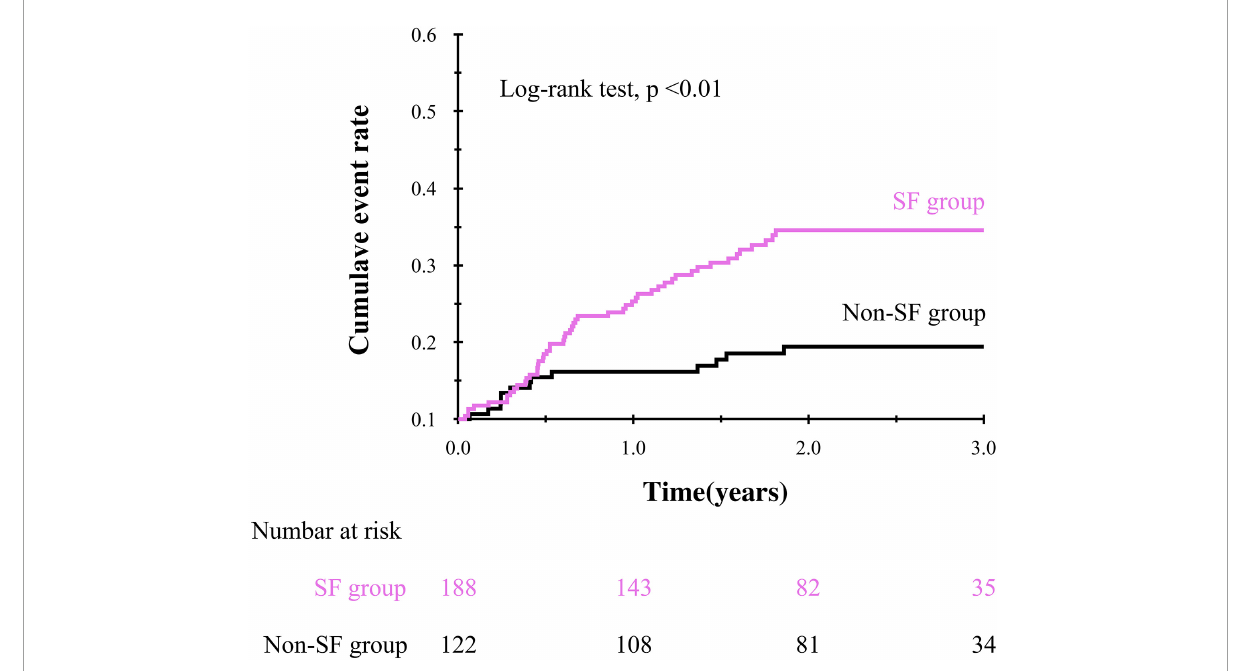
FIGURE2 Kaplan-Meier curve showing the impact of social frailty on the composite event in older HF